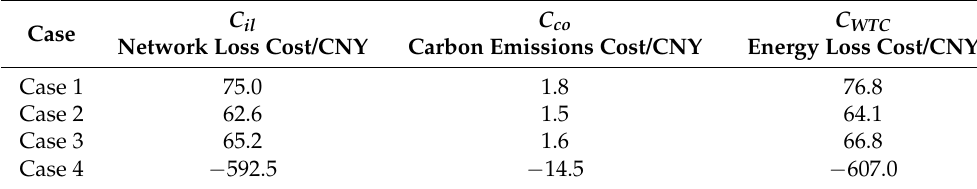
Table 5. Network loss cost and energy loss cost in the four cases.